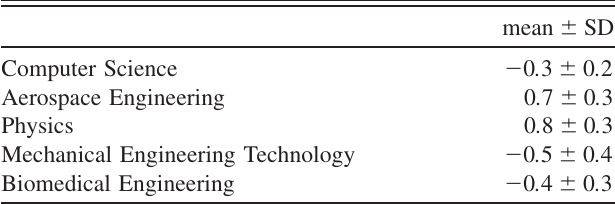
TABLE V. Effect of major in phase 2. For brevity, we list only the majors with nonzero